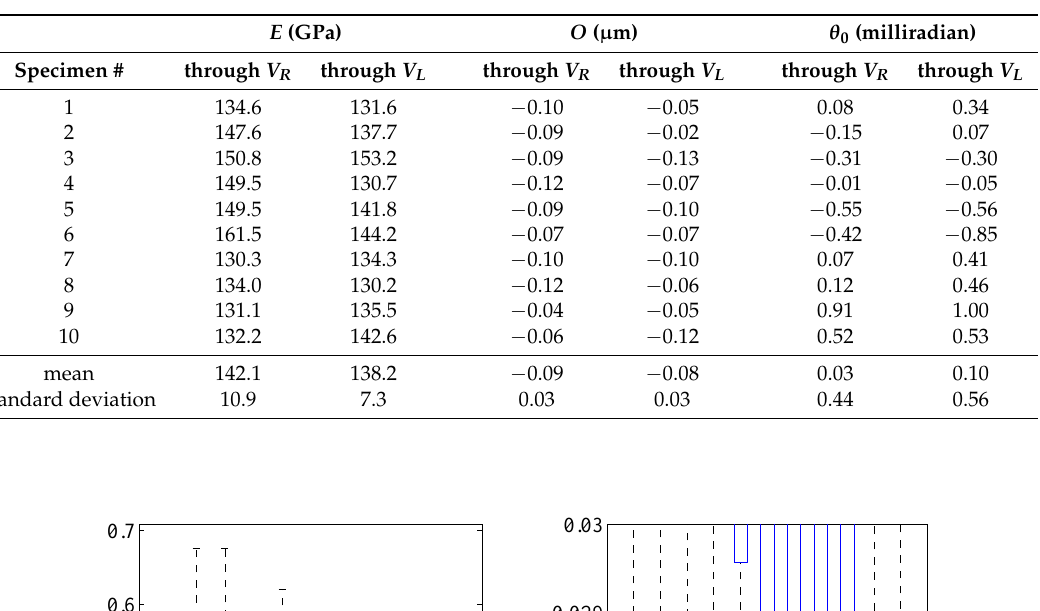
Table 2. Spacimen- and actuation-dependent values of model parameters E , O and θ 0 estimated by the GA.